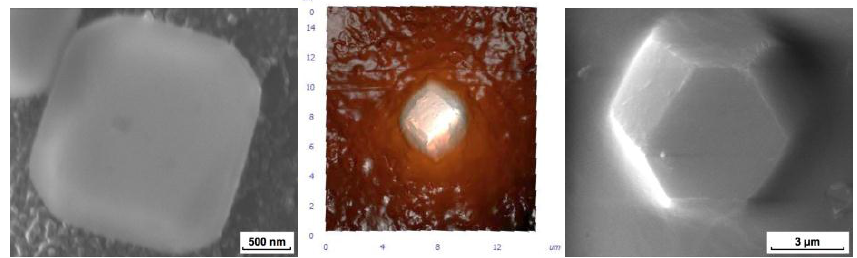
Fig. 1. SEM and AFM images of obtained single crystals of